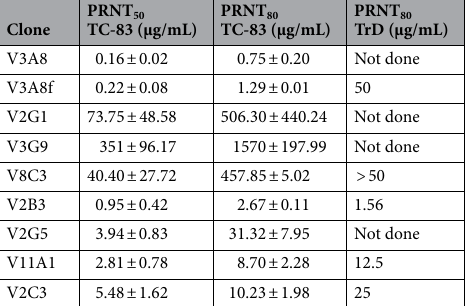
Table 3. Neutralization of VEEV strains by standard